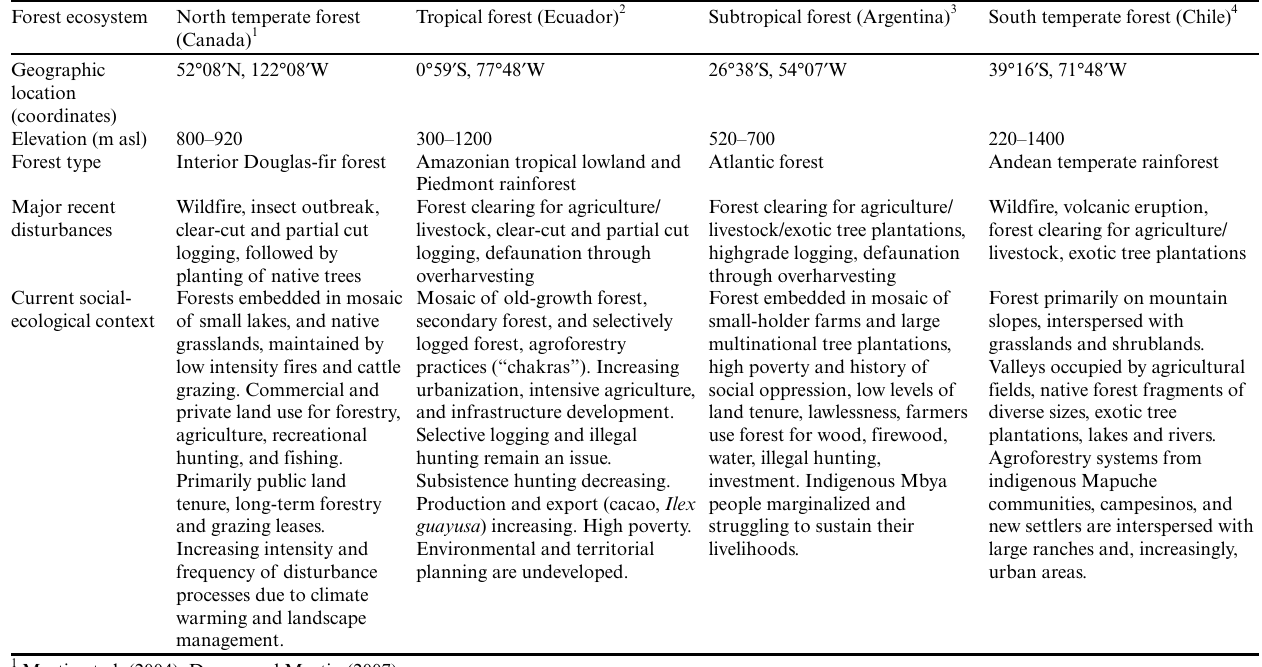
Table 2 . General attributes of forest ecosystems presented in this paper. Forest ecosystem